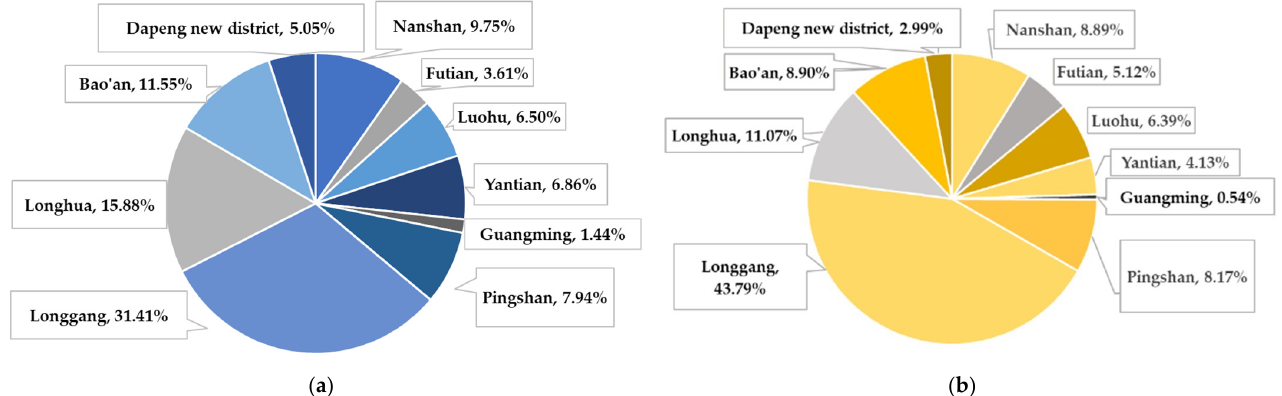
Figure 3. ( a ) Quantity and ( b ) area proportion distribution of urban village redevelopment.